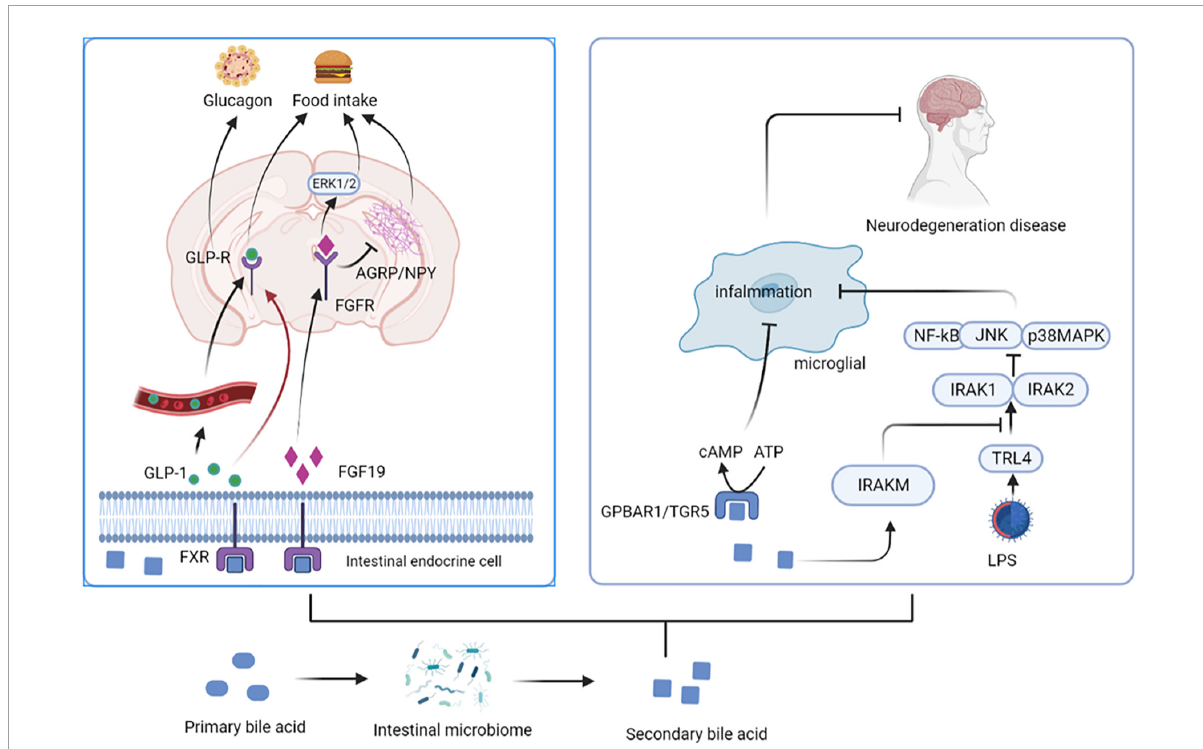
FIGURE2 Secondary bile acids affect central nervous system activity. BAs stimulate the release of GLP-1 and FGF19 by activating FXR in the gut. Intestinal GLP-1 activates the brain by activating vagal afferent fibers, influencing feeding behavior and blood sugar levels. FGF19 induces anorexia by binding to FGFR, inducing ERK1/2 signaling and inhibiting AGRP/NPY neuronal activity. UDCA activates GPBAR1 and increases cAMP levels, thereby mediating its anti-inflammatory effect on microglia. In addition, TUDCA induces the transcription of IRAK-M, an inhibitor of the NF- κ B pathway, which inhibits the activity of IRAK-1 and IRAK-2 kinases induced by the activation of the LPS-TLR4 pathway. UDCA, ursodeoxycholic acid; TUDCA, tauroursodeoxycholic acid; FGF19, fibroblast growth factor 19; FGFR, fibroblast growth factor receptor; FXR, farnesoid X receptor; ARC, arcuate nucleus; ERK, extracellular signal regular-regulated kinase; AGRP/NPY, gonadotropin-releasing hormone-related peptide/neuropeptide Y; GPBAR1, G protein-coupled bile acid receptor 1; cAMP, cyclic adenosine monophosphate; IRAK, interleukin-1 receptor-associated kinase; NF- κ B, nuclear factor kappa-B; LPS, lipopolysaccharide; TLR4, toll-like receptor